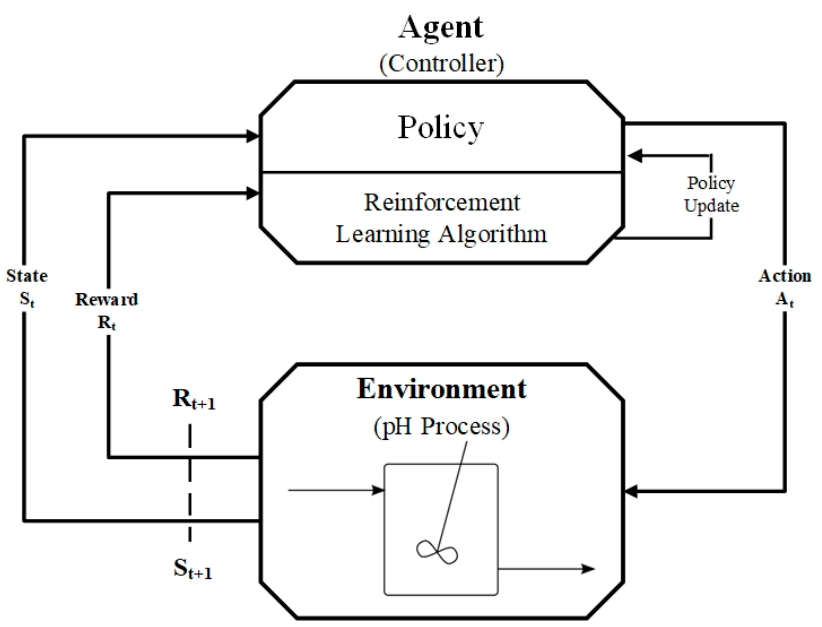
Figure 1. An overview of the RL structure.